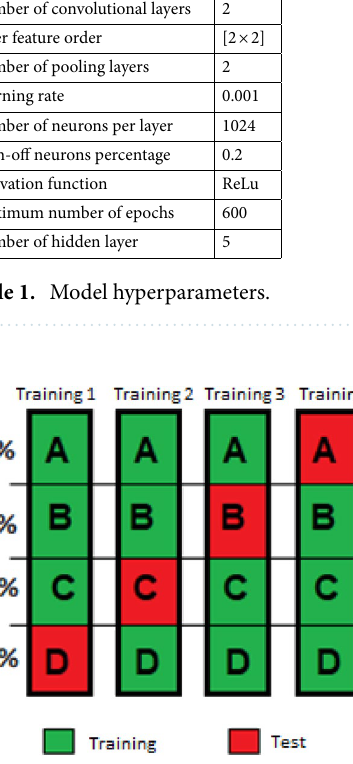
Figure 2. Visual presentation of a fourfold cross